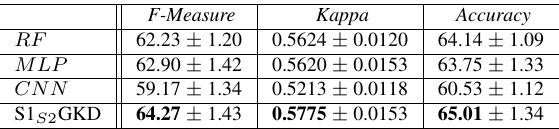
Table 5. F-Measure, Kappa and Accuracy considering S1 S 2 GKD and different competing methods. (Average over ten random splits)